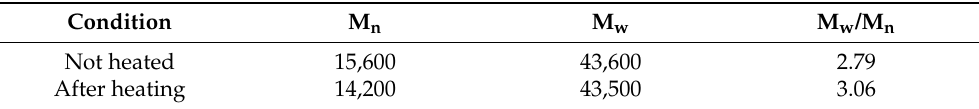
Table 1. The average molecular weights of PA66 before and after heating, as determined by GPC measurement.